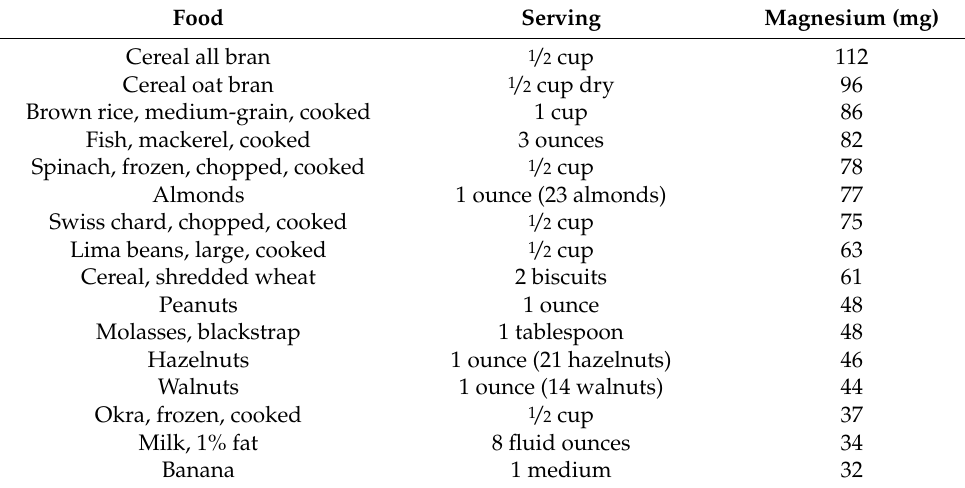
Table 1. Some Food Sources of